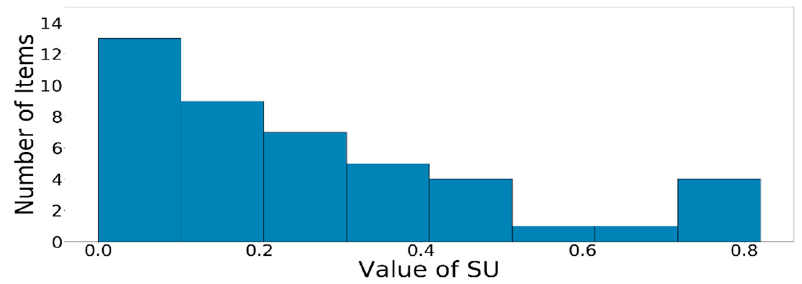
Figure 3. The distribution of (cid:1845)(cid:1847)((cid:1858) (cid:3036) , (cid:1855)) .